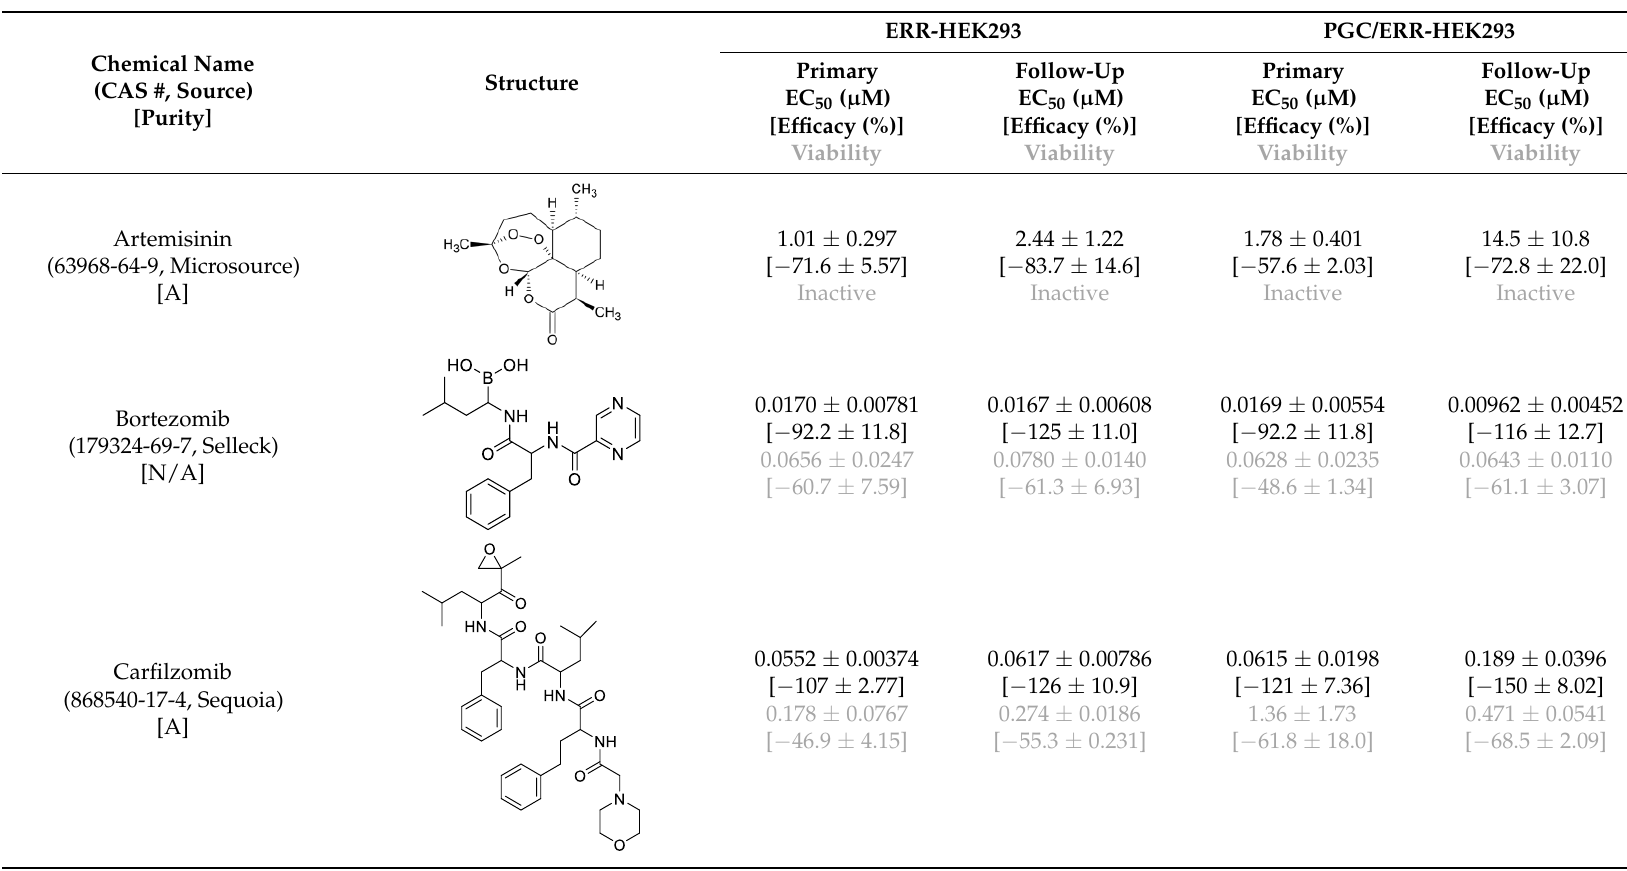
Table 1. Antineoplastic agents quantitative high-throughput screening (qHTS) primary and confirmation estrogen-related receptor (ERR) and peroxisome proliferator